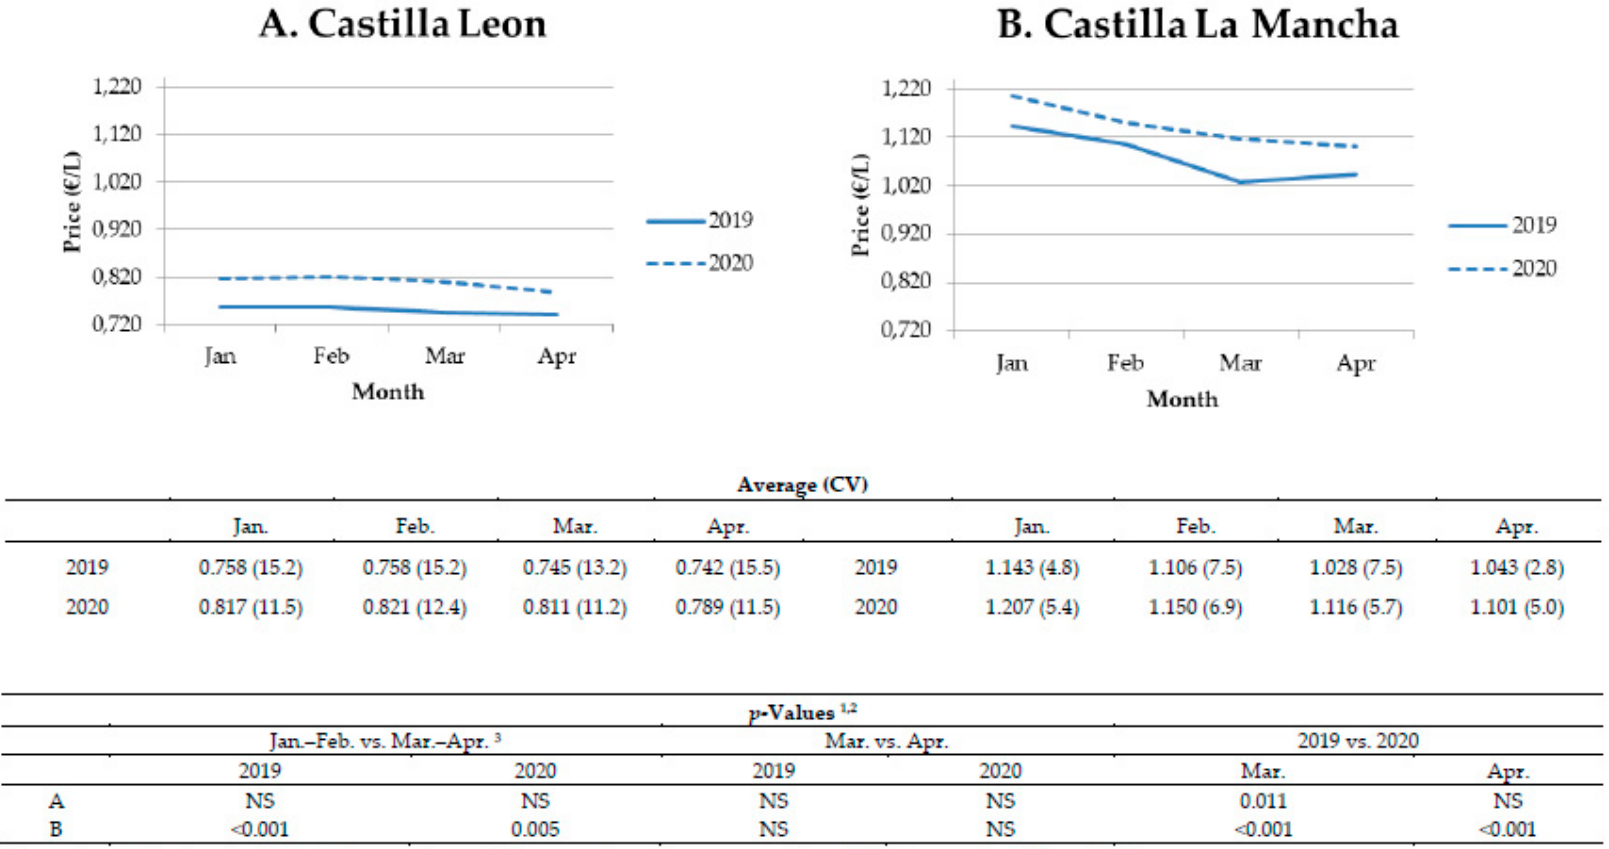
Figure 3. Average monthly price per liter of sheep milk (EUR/L) reported by producers from January to April 2019 and 2020 according to area (coefficient of variation, %), with intra- and interannual comparisons. Data from 21 dairy sheep flocks.